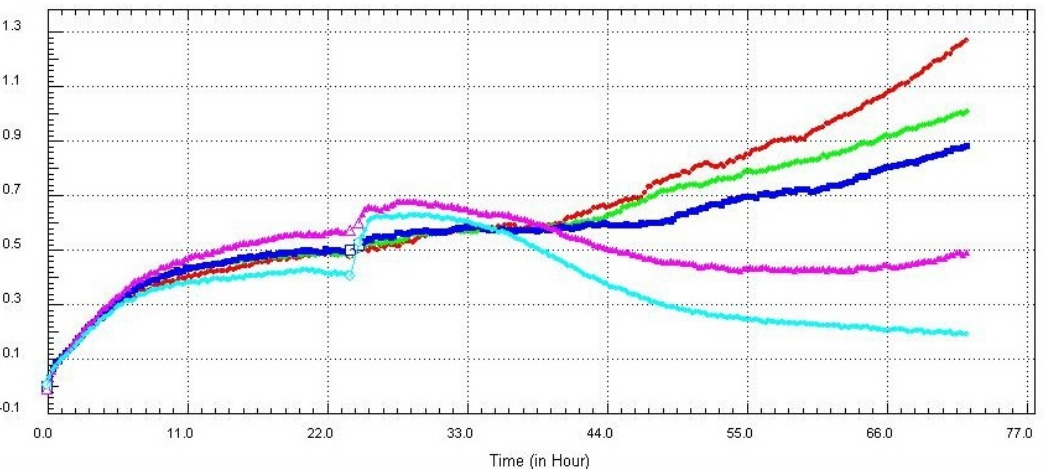
Figure 4. RTCA screening of PAECs. Cells were seeded at 0 h and GPs were administrated at 24 h. Cell growth was monitored for the following 48 h. Deep red (5 μ g/mL), green (10 μ g/mL), deep blue (20 μ g/mL), purple (50 μ g/mL), turquoise (100 μ g/mL).